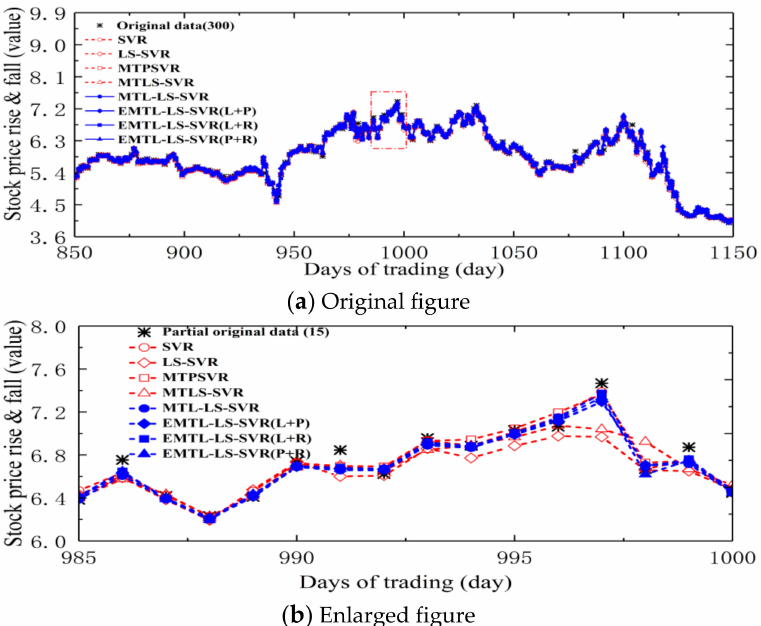
Figure 12. Predictions of different regression models on stock opening price for CCB ( a ) Original figure, ( b ) Enlarged